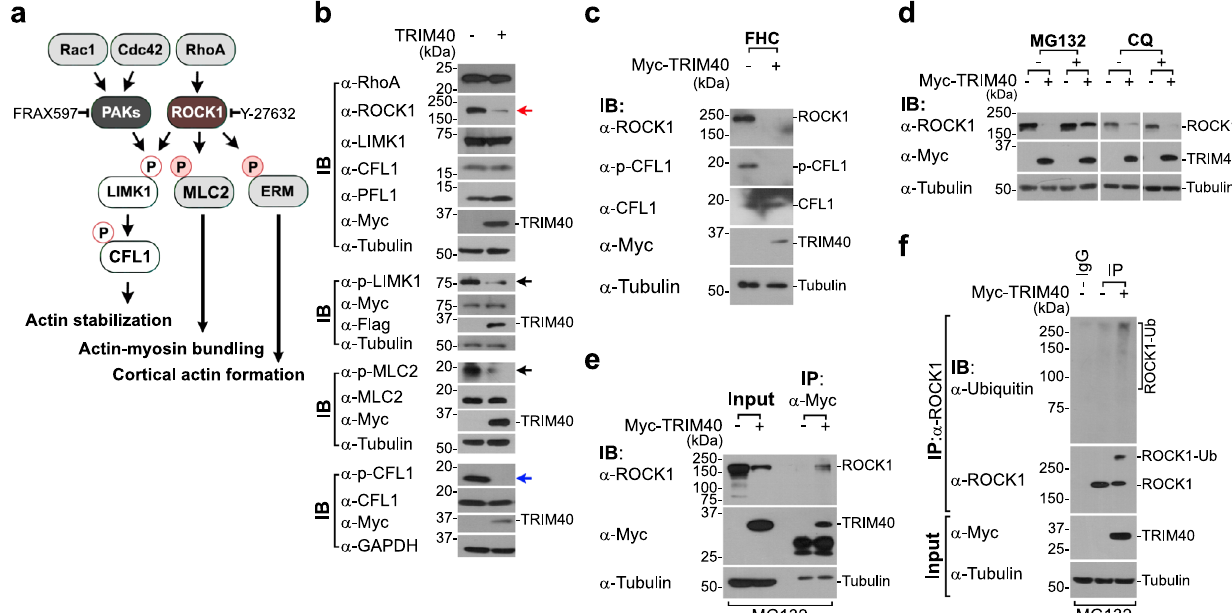
Fig. 3 | TRIM40 regulates RhoA – ROCK1 signaling by promoting ROCK1 degradation.a Schematicrepresentationofactincytoskeletonsignalingpathways by Rho family GTPases. b Immunoblot analysis for the expression of signaling proteins associated with the actin cytoskeleton in HT-29 cells expressing control vectororMyc-TRIM40. Cell extracts were analyzedusing the indicatedantibodies. For p-LIMK1 levels, lysates from cells expressing LIMK1-Myc with control vector or Flag-TRIM40 were immunoblotted with the indicated antibodies. Tubulin and GAPDH were used as a loading control. c Immunoblot analysis of ROCK1, p-CFL1, and CFL1 levels in FHC cellsexpressing control vector or Myc-TRIM40. Cell lysates were analyzed using the indicated antibodies. Tubulin was used as a loading con- trol. d Immunoblot analysis of ROCK1 protein levels in HT-29 cells expressing control vector or Myc-TRIM40 after treatment with MG132 (10 µ M) or chloroquine